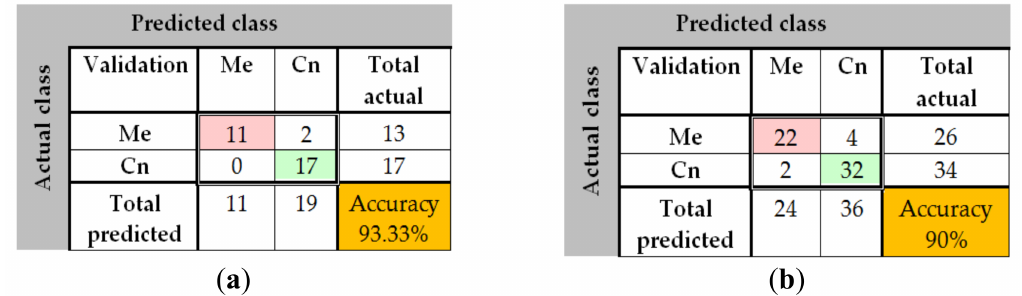
Figure 30. ( a ) Confusion matrix for validation phase in the case of Feature-based method for PH 2 database; ( b ) Confusion matrix for validation phase in the case of Feature-based method for ISIC 2019 database.